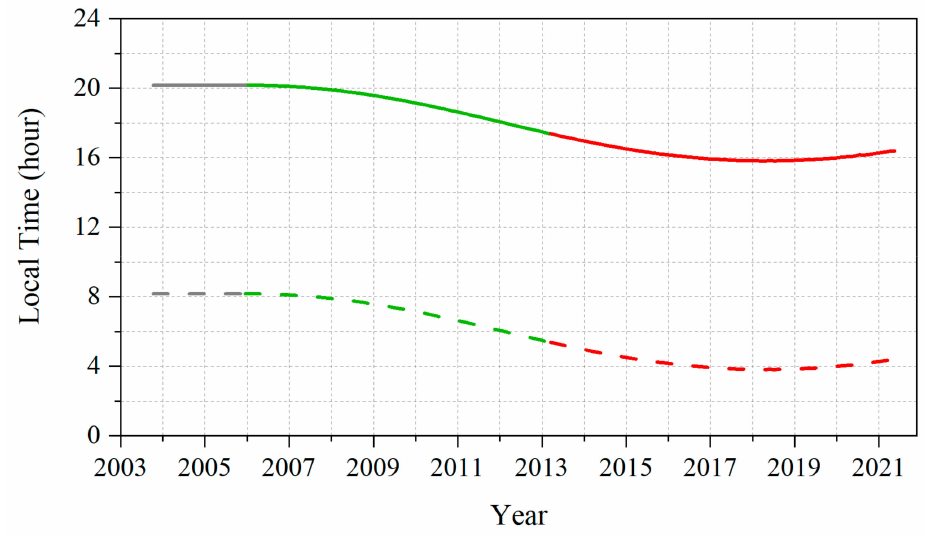
Figure 1. Variations of LECT at the ascending (solid curve) and descending (dashed curve) nodes of F16. Three time periods are also indicated: no available data (gray curve), high-quality data (green curve, from 20 November 2005 to 25 April 2013, and noisy data (red curves, from 25 April 2013 to 15 June 2021) in LAS channels TB